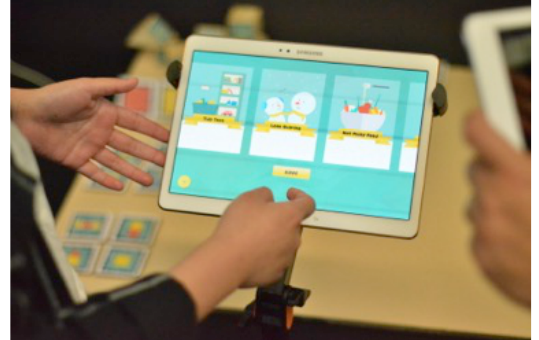
Figure 4. ‘Save’ star button of Parent Mode